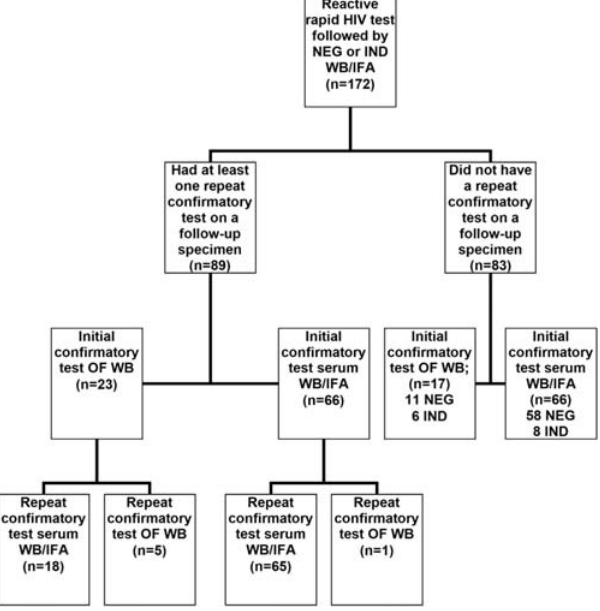
Figure 1. Repeat confirmatory testing practices after a reactive rapid HIV test and negative or indeterminate WB/IFA. WB=Western blot, IFA=Immunofluorescent assay, OF=oral fluid, IND=indeterminate,